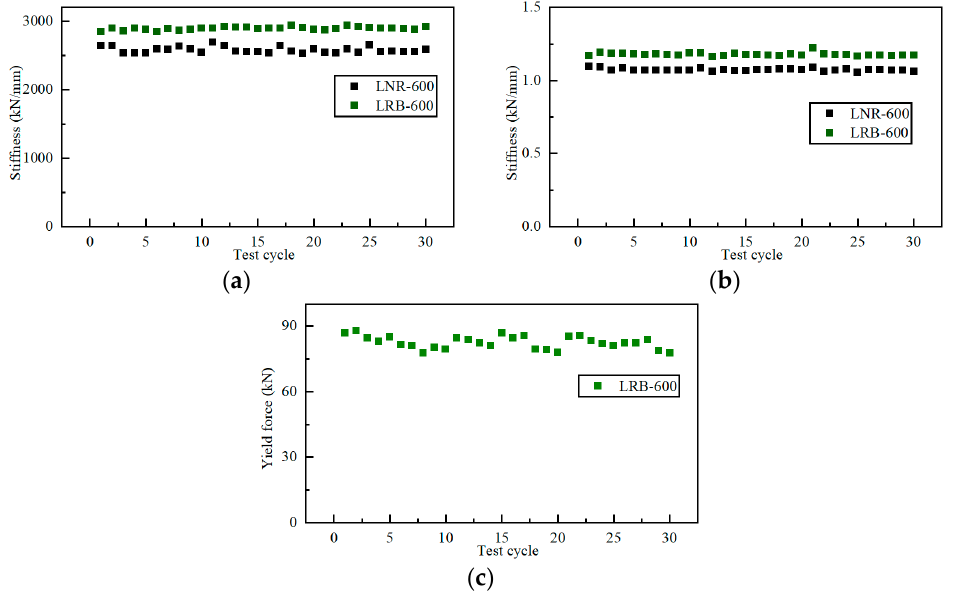
Figure 11. The mechanical properties of the specimens in the cyclic test: ( a ) vertical stiffness; ( b ) horizontal stiffness; ( c ) yield force.